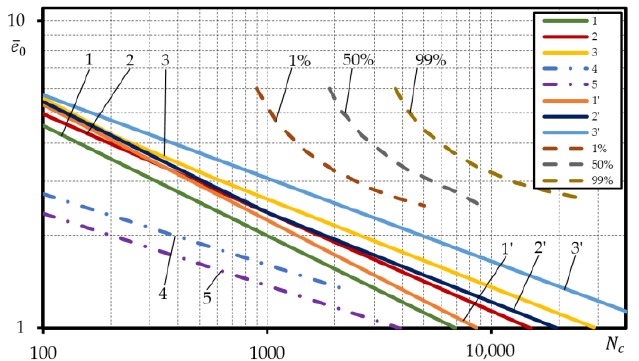
Figure 12. Comparison of the probabilistic low-cycle fatigue curves calculated under strain-controlled loading with the experimental ones for steel C45; straight lines — calculated, dashed lines – experiment; normalized characteristic according to: 1 — Equation (3), 2 — Equation (5), 3 — Equation (6); reference characteristics, according to: 1′— Equation (3 ), 2′—Equation (5), 3′— Equation (6); calculated, according to: 4 — Equation (3) if n e = 2, 5 — Equation (3) if n N = 10 .